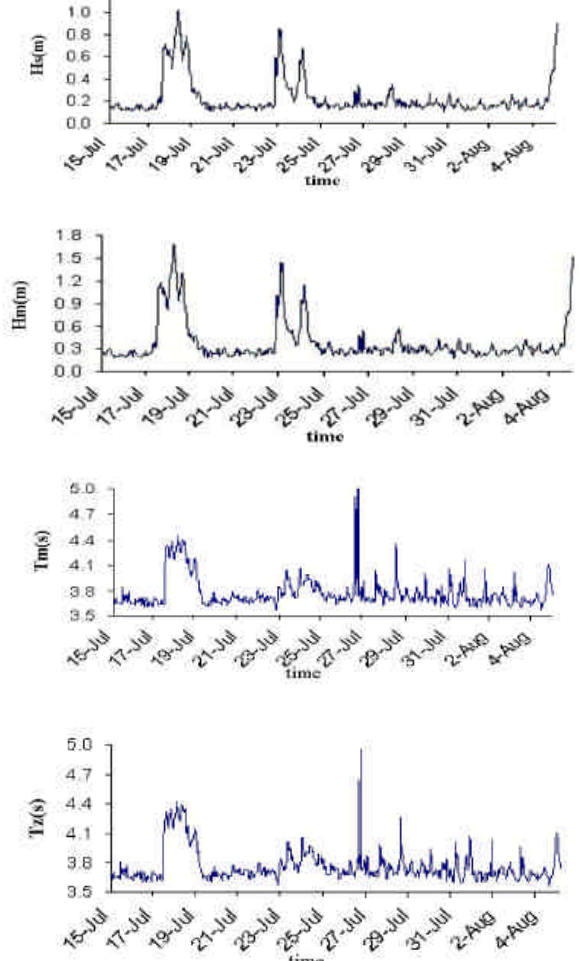
Figur7. Hourly time series significant wave height (Hs), maximum wave height (Hm), Fig. 7. Hourly time series significant wave height ( H s ), maximum wave height ( H m ), wave period corresponding to H m (T m ) and zero wave period corresponding to Hm(Tm) and zero crossing period (Tz),. crossing period ( T z